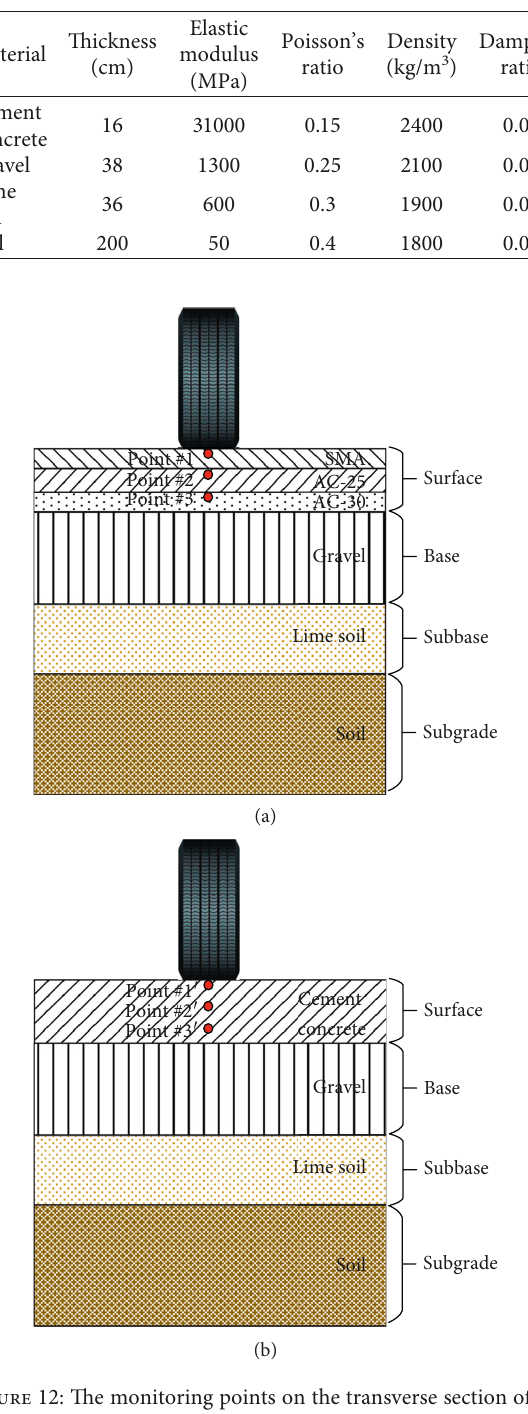
Table 3: The material parameters of cement concrete pavement.